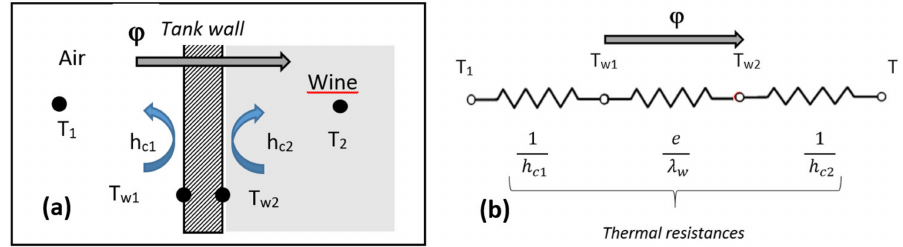
Figure 6. Sketch of the heat transfer mode ( a ), and electrical analogy of the thermal resistances ( b ), with ϕ being the total resistance against heat transfer, T 1 the ambient air temperature outside the tank, T 2 the wine temperature, T w1 the temperature of the external wall of the tank and T w2 the temperature of the inner wall, h c1 the external convective coe ffi cient, h c2 the internal convective coe ffi cient, and λ w the thermal conductivity of the tank wall whose thickness is denoted e